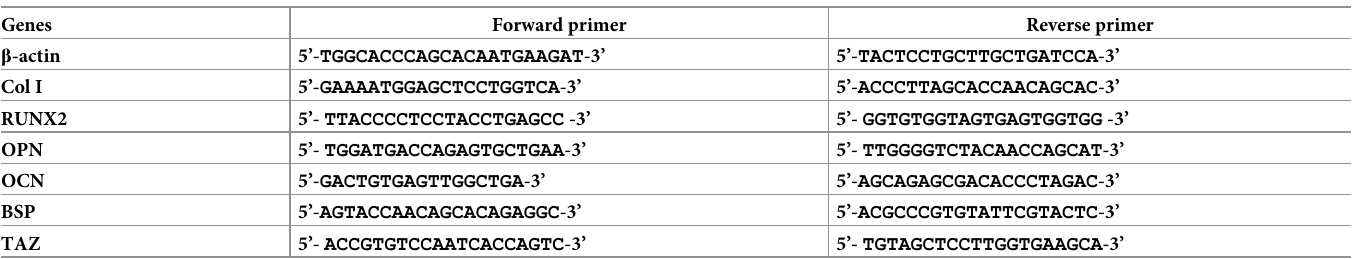
Table 1. Sequence of primer used in the real-time